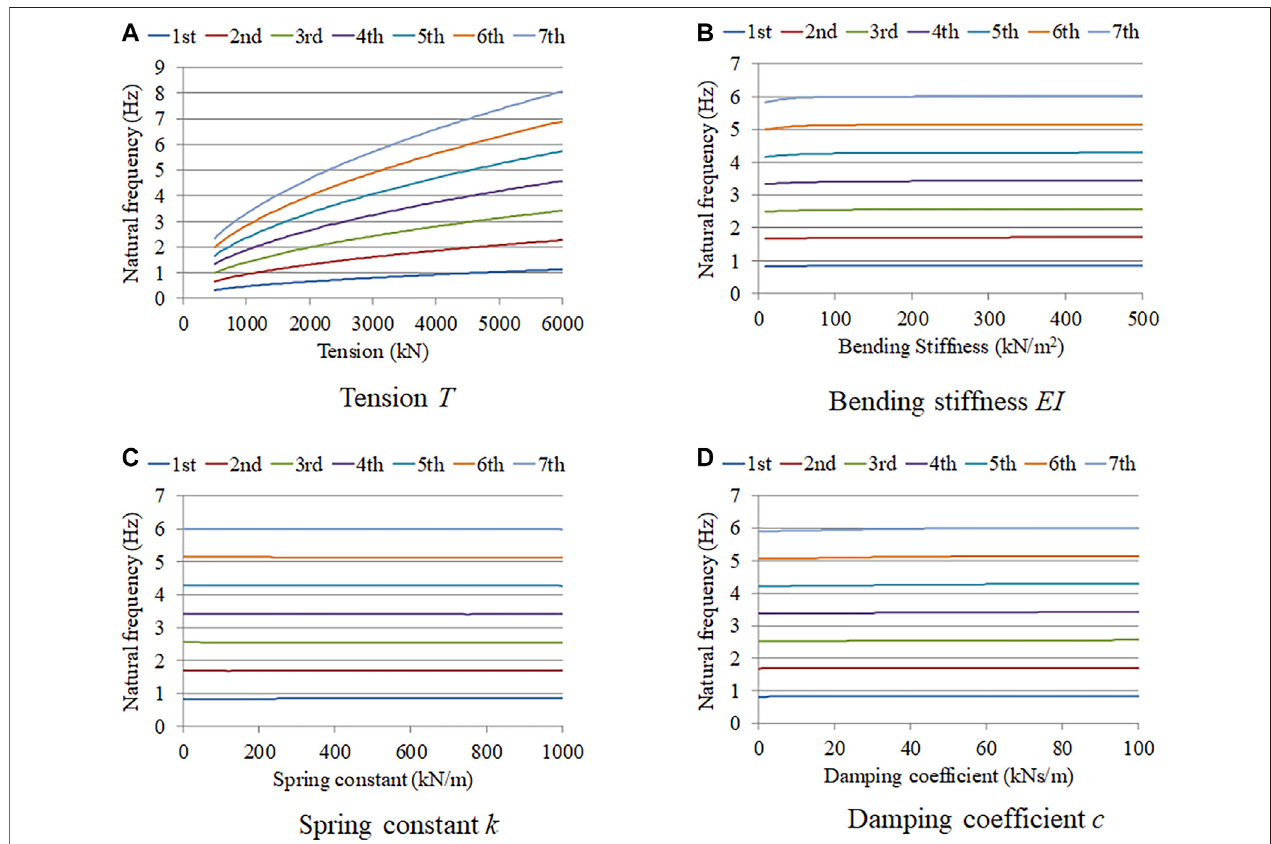
FIGURE 6 | Sensitivity analysis results for viscous shear damper: (A) tension; (B) bending stiffness; (C) spring constant; (D) damping coef fi cient.